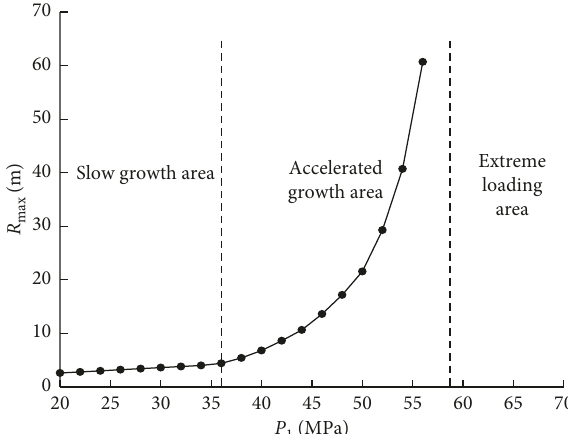
Figure 4: Relationship between maximum radius of plastic zone and maximum confining